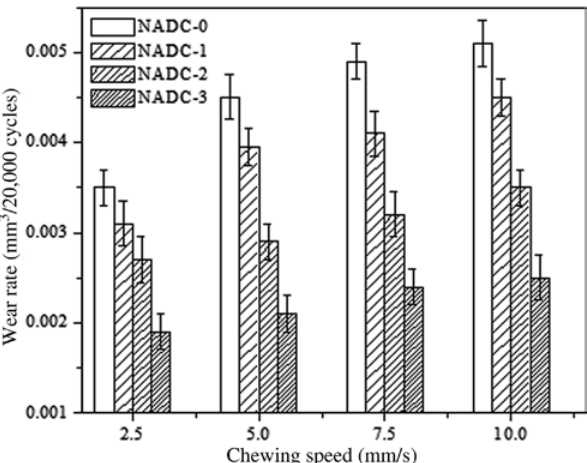
Figure 5: Effect of chewing speed on volumetric wear rate of the dental composites in food slurry condition (at constant normal load of 40 N and chamber temperature of 25 ° C).